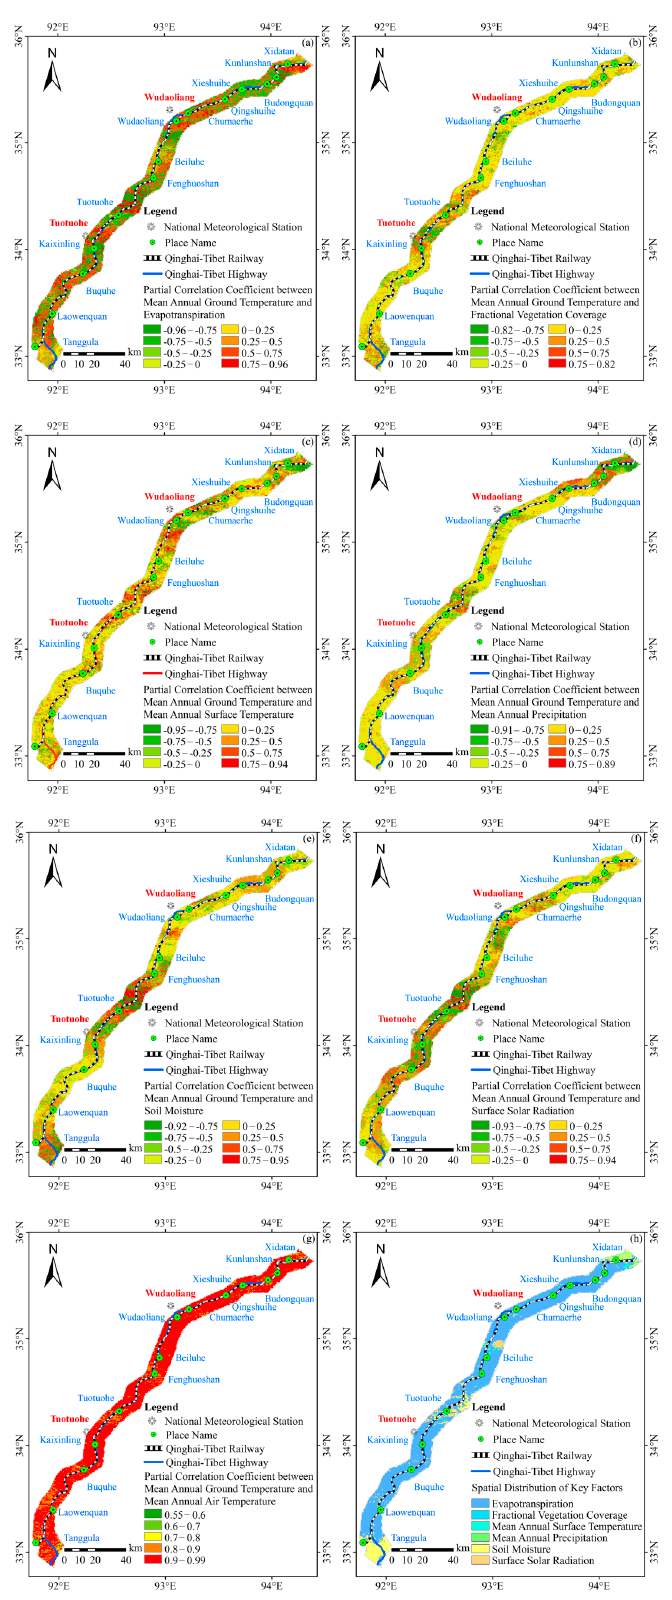
Figure 15. Spatial distribution of the partial correlation coefficient between MAGT and driving factors, and key factors affecting MAGT: ( a ) ET; ( b ) FVC; ( c ) MAST; ( d ) MAP; ( e ) SM; ( f ) SR; ( g ) MAAT; ( h ) key factors.